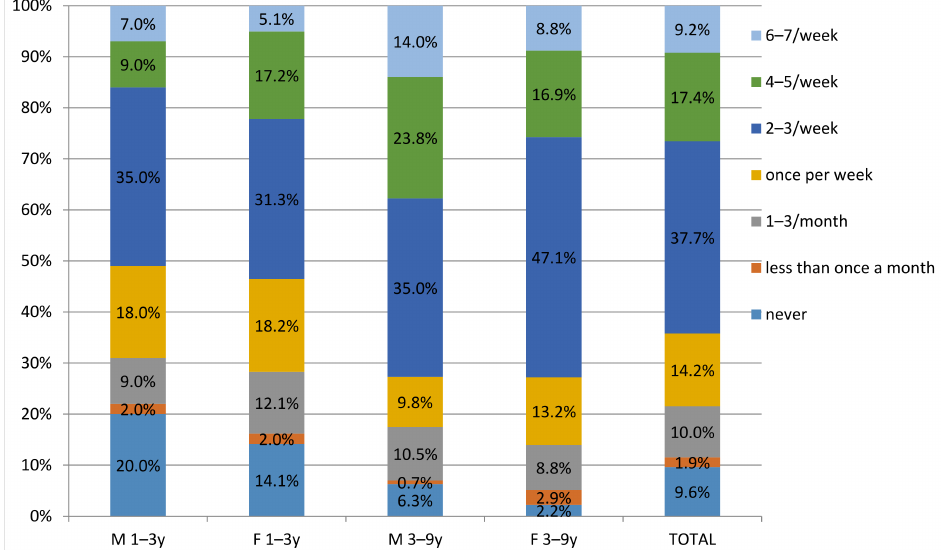
Figure 1. Frequency of consumption of meat products in children 1–9 in Serbia by Food Propensity Questionnaire